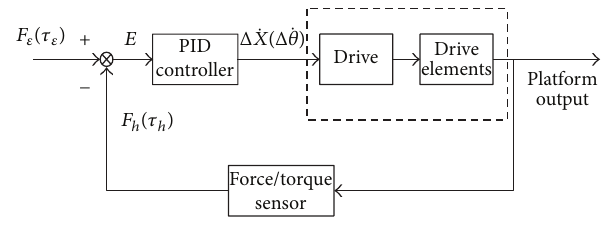
Figure 4: Force closed-loop control